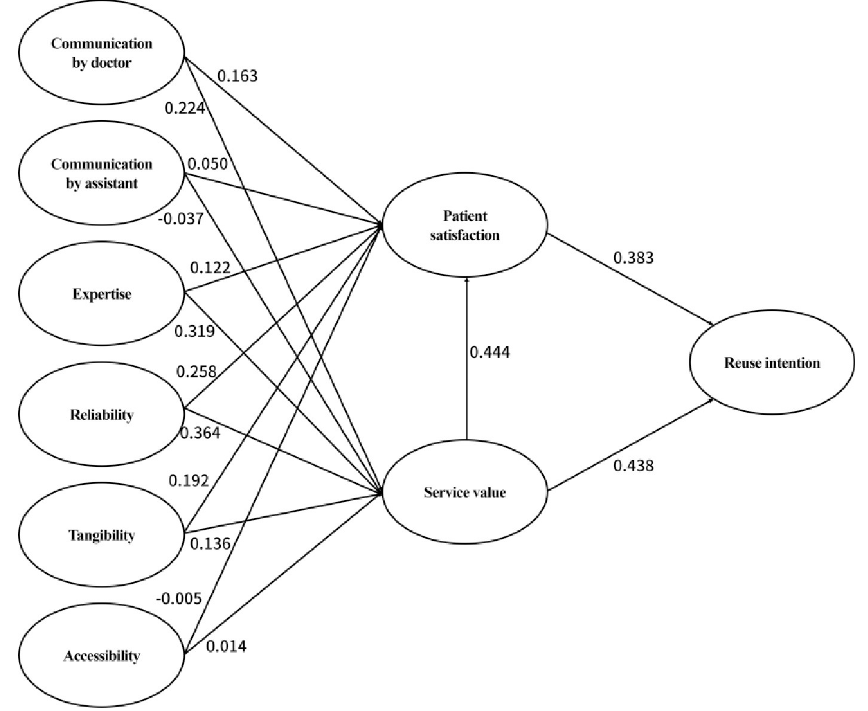
Fig 2. Final path